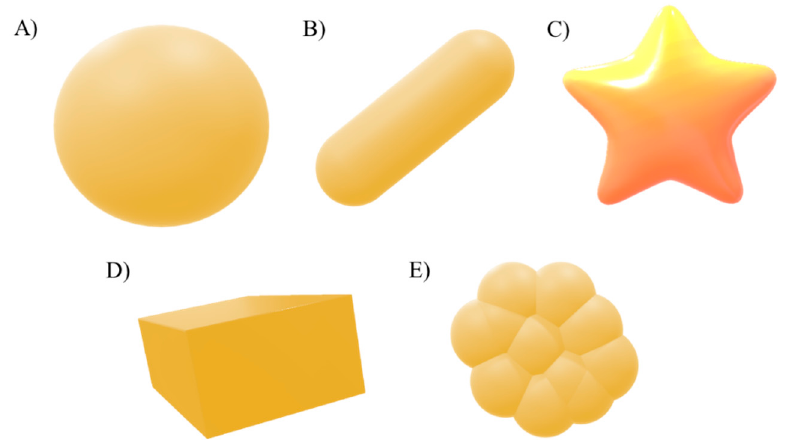
Figure 4. Common shapes of AuNPs; sphere ( A ), rod ( B ), star ( C ) triangles, rods, stars and cubic ( D ) and triangle-like ( E ) prisms (based on [155]). Table 2. Summary of reduction of toxicity strategies employed in metal nanoparticles and the techniques used to assed their characterization and therapeutic efficacy (ND: no data available).